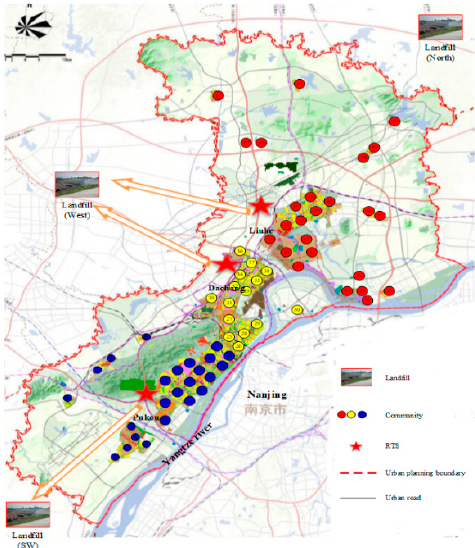
Figure 4. Allocation of each community.